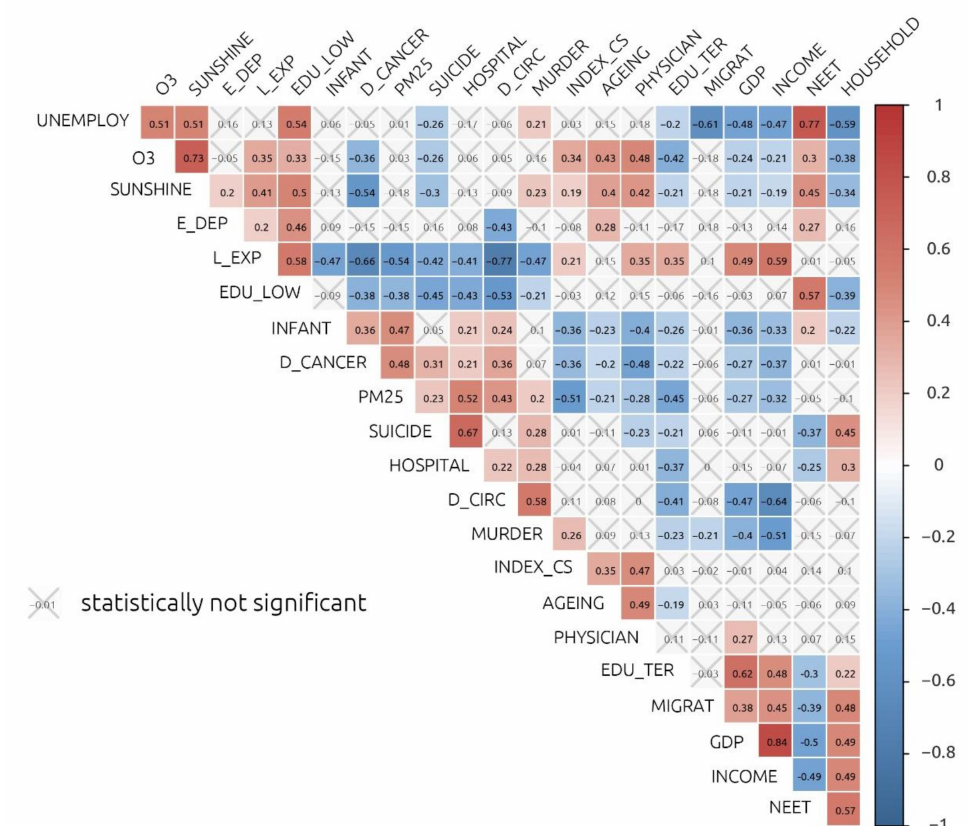
Figure A1. Correlation matrix for all input objective indicators.